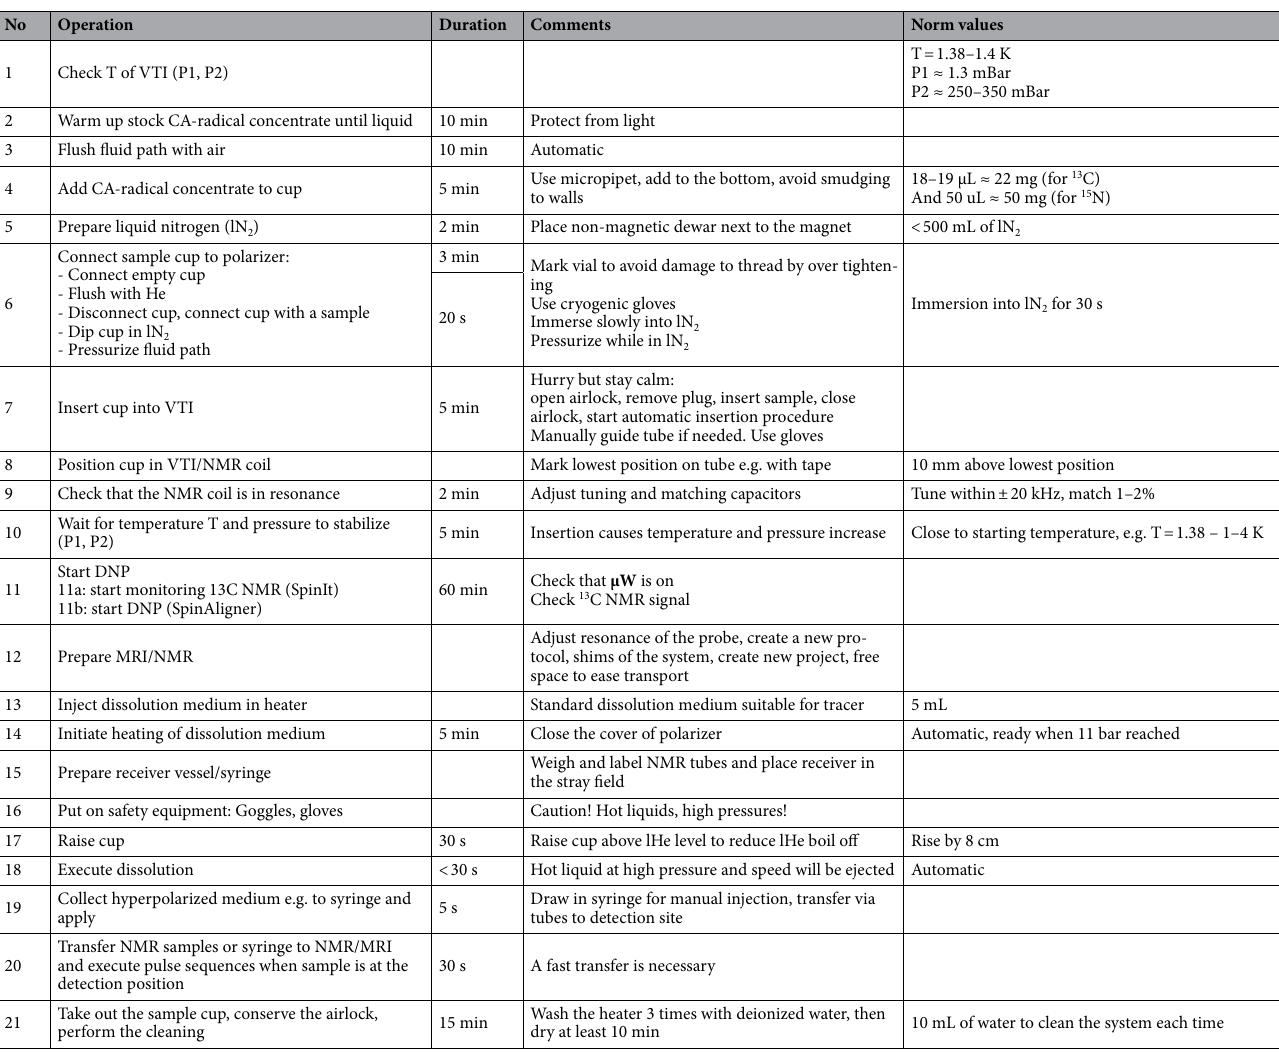
Table 5. Standard operational procedure for dDNP experiments.